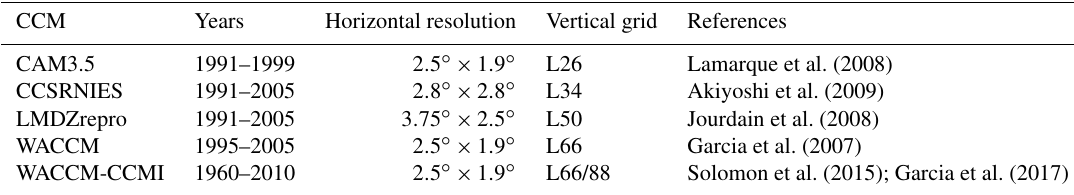
Table 3. Horizontal resolution and number of levels for the CCMs used. The output of the models has been taken for the years indicated in the second column.